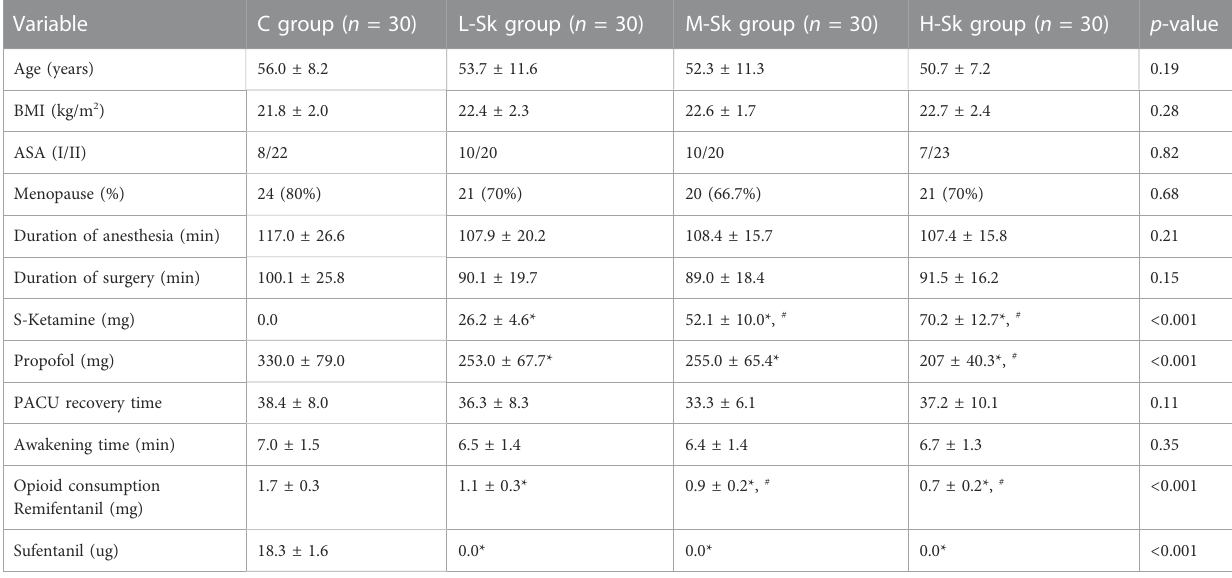
TABLE 1 Demographic data and perioperative